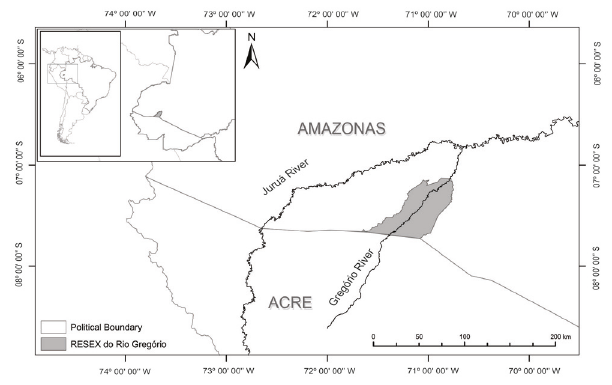
Figure 1. Study site, Reserva Extrativista do Rio Gregório, a protected area in Amazonas state, southwest Amazonia,